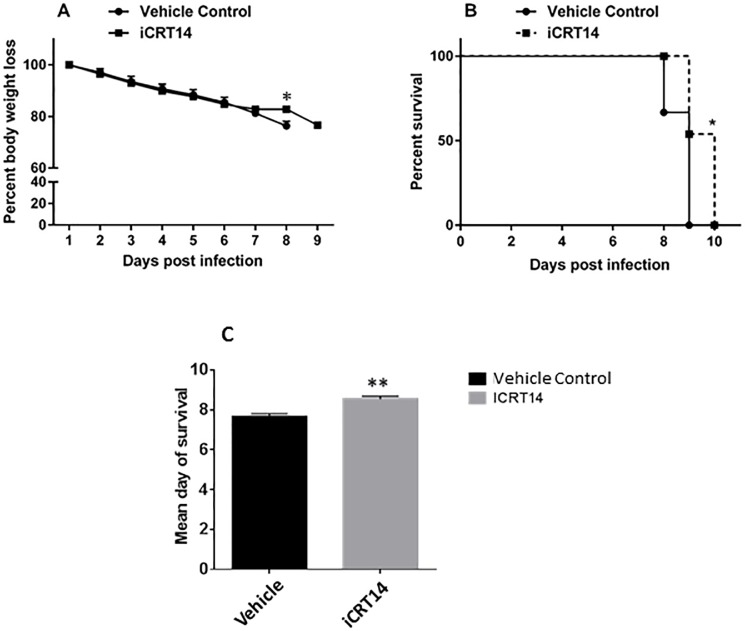
Effects of iCRT14 on weight loss and survival rate in mice challenged with a lethal dose of influenza virus A/PR/8/34.C57BL/6J mice were treated with iCRT14 (50 mg/kg) or vehicle control daily from one day prior to infection until day 6 post-infection. The mice were challenged with influenza virus A/PR/8/34 (1,000 pfu/mouse). (A) Percent of body weight loss. Body weight loss is presented as the mean ± SE. *p < 0.05 vs. vehicle control at day 8 (Two-way ANOVA followed by post-hoc sidak test). (B, C) Kaplan–Meier survival curves and mean day of survival of mice in the iCRT14 and vehicle control groups. The Mantel-Cox χ2 test and Student’s t-test were used for survival curves and mean day of survival, respectively. *p< 0.05 vs. control group; **p<0.01 v.s control group, n = 12–13 animals per group.